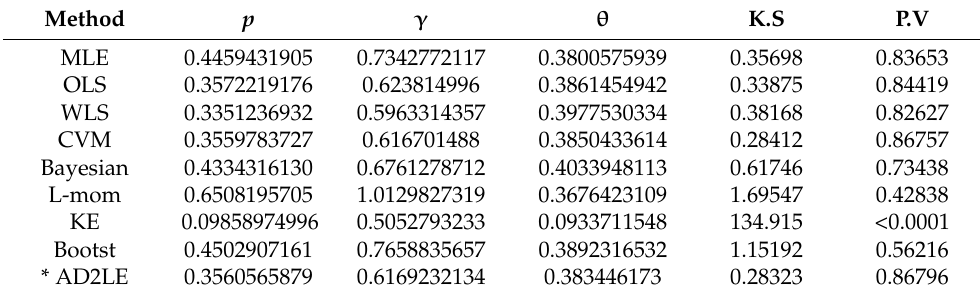
Figure 5. Kaplan–Meier plots according to dataset III. Table 10. Comparing methods using dataset